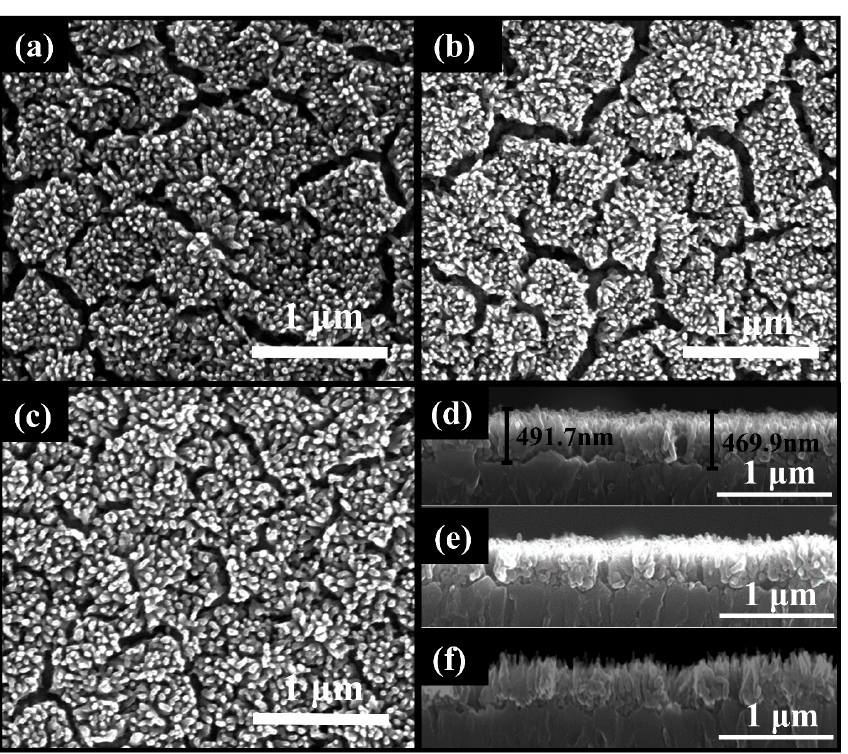
Figure 1. The top-view scanning electron microscopy (SEM) images of ( a ) pristine Ti-Fe 2 O 3 , ( b ) OPT-100W-150s, and ( c ) OPT-200W-70s photoanodes; cross-sectional images of ( d ) pristine Ti-Fe 2 O 3 , ( e ) OPT-100W-150s, and ( f ) OPT-200W-70s photoanodes.